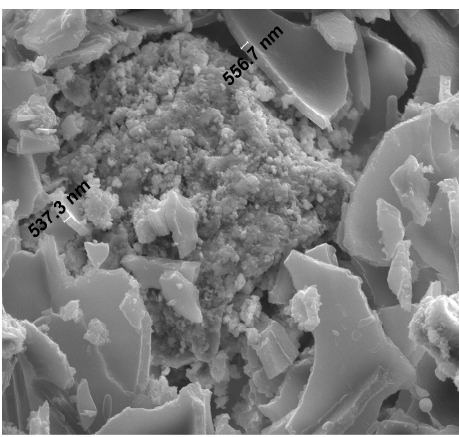
Figure 16. Compact calcium silicate hydrate (C-S-H) phase surrounded by the Ca(OH) 2 portlandite crystals at 1000× magnification.